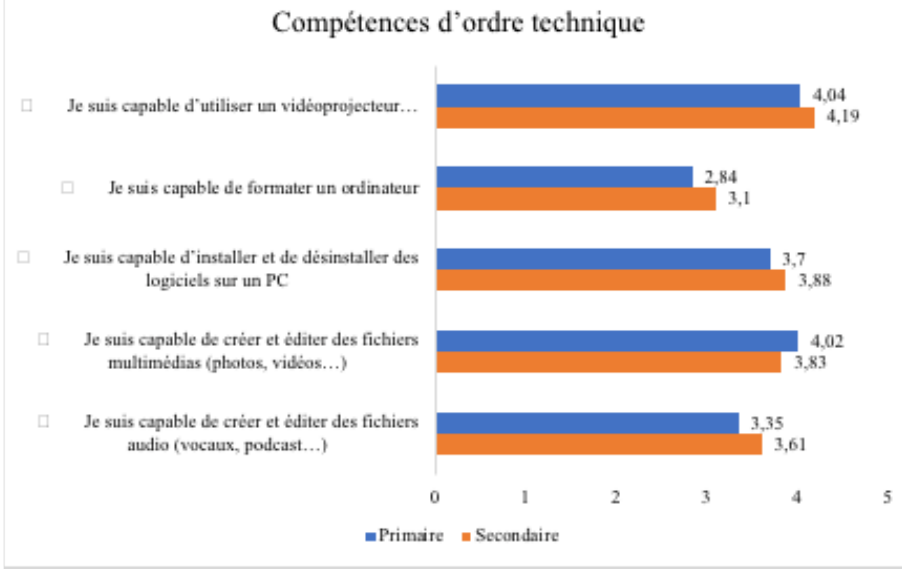
Fig.10. les compétences d’ordre technique déclarées maitrisées à l’issu de la formation au CRMEF.